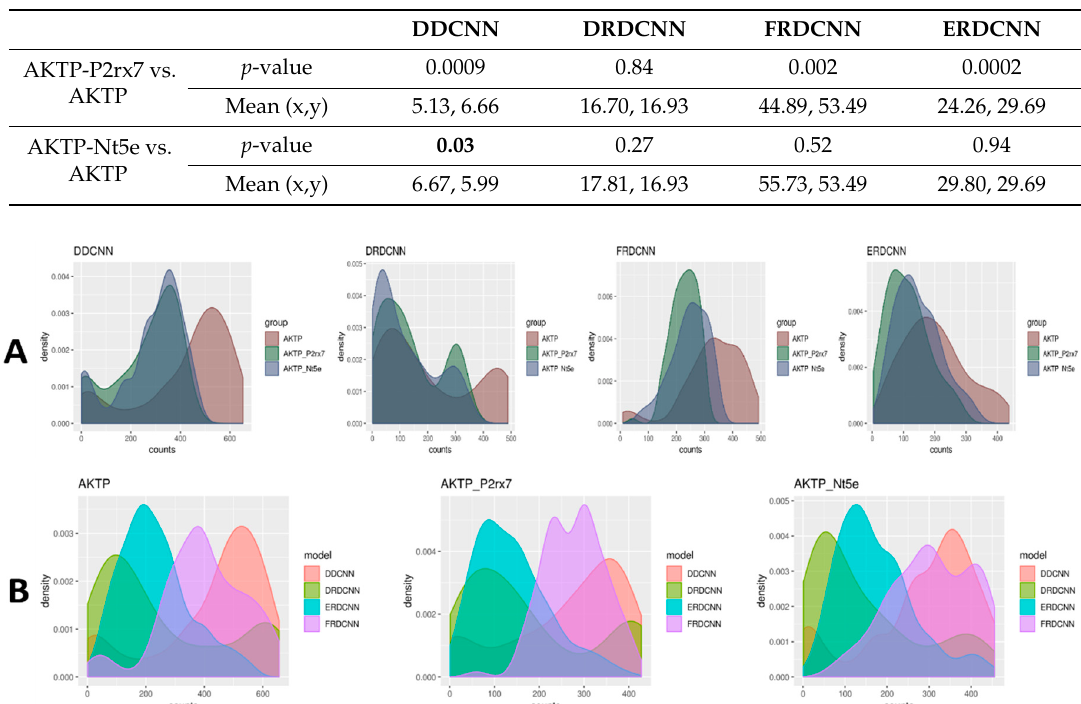
Table 4. Results of the t-tests evaluating the predicted cell counts under the three di ff erent conditions using the di ff erent DCNN models.